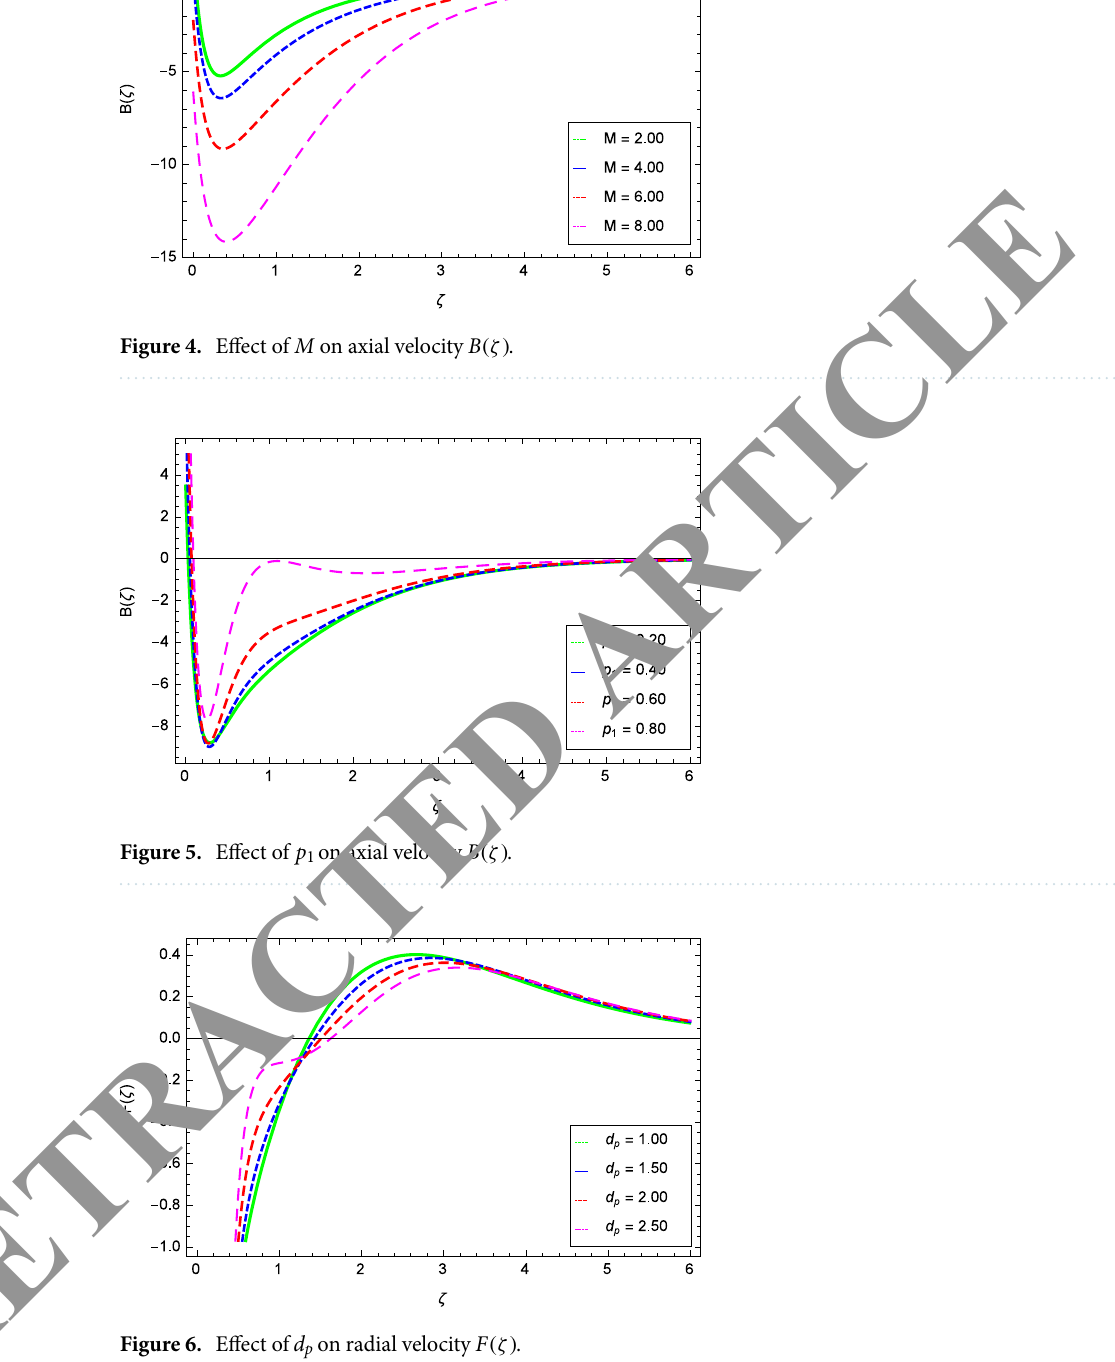
Figure 6. Effect of d p on radial velocity F (ζ) .